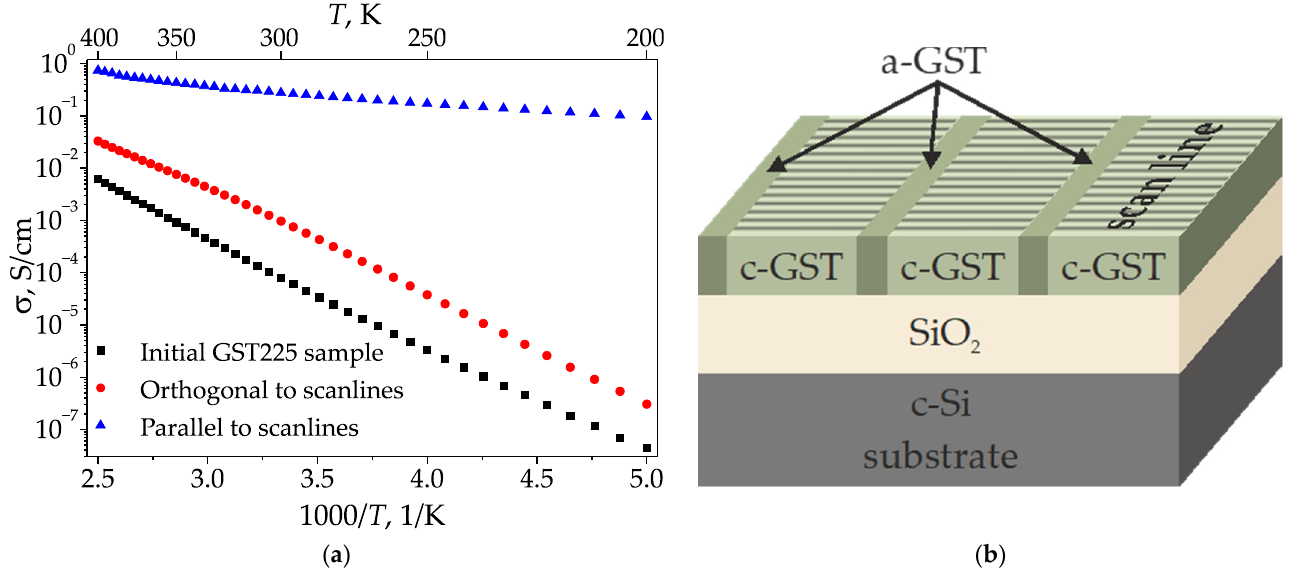
Figure 4. Temperature dependencies of conductivity ( a ) for the as-deposited sample and for the irradiated areas along and orthogonal to the scanlines. The scheme of crystalline and amorphous phases distribution inside the irradiated GST sample ( b ). Thin horizontal stripes indicate the presence of LIPSS within the scanlines; a-GST is amorphous GST225, c-Si and c-GST are crystalline silicon and crystalline GST225, respectively.